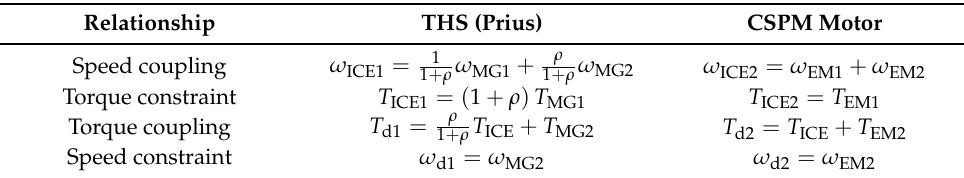
Table 1. The comparison of the power transmission system mathematical models of THS and the CSPM